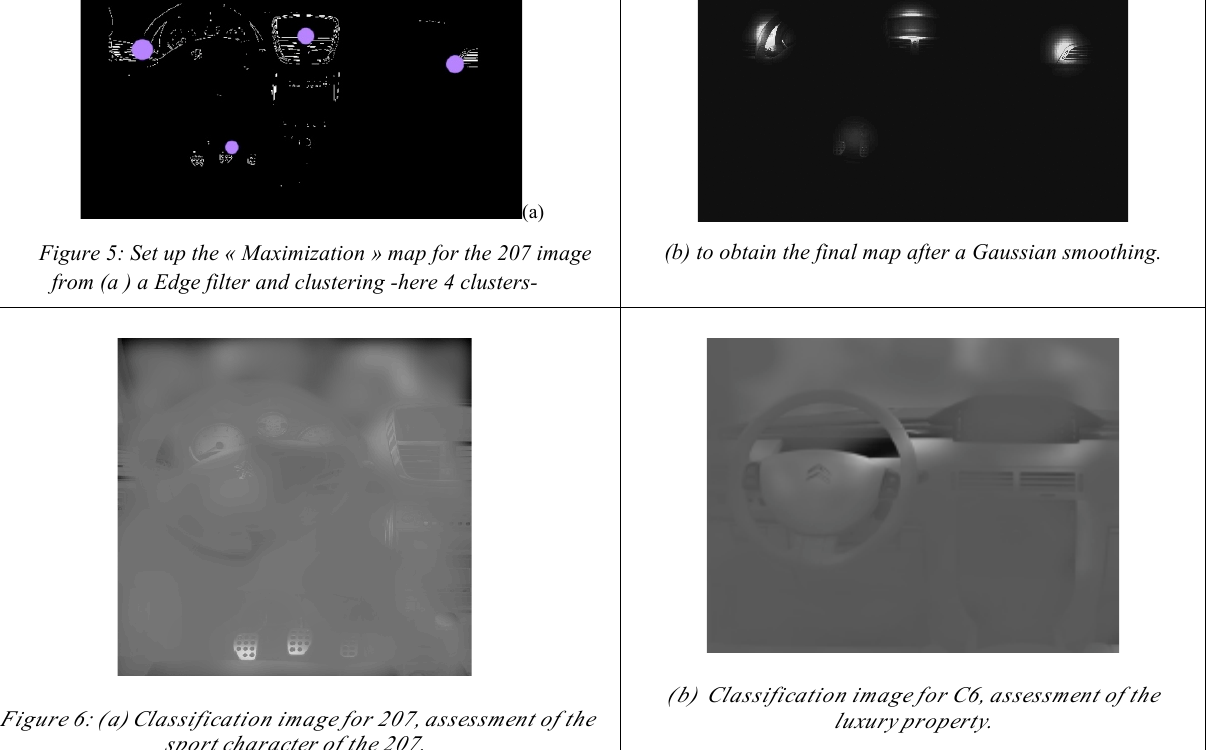
Figure 6: (a) Classification image for 207, assessment of the sport character of the 207.